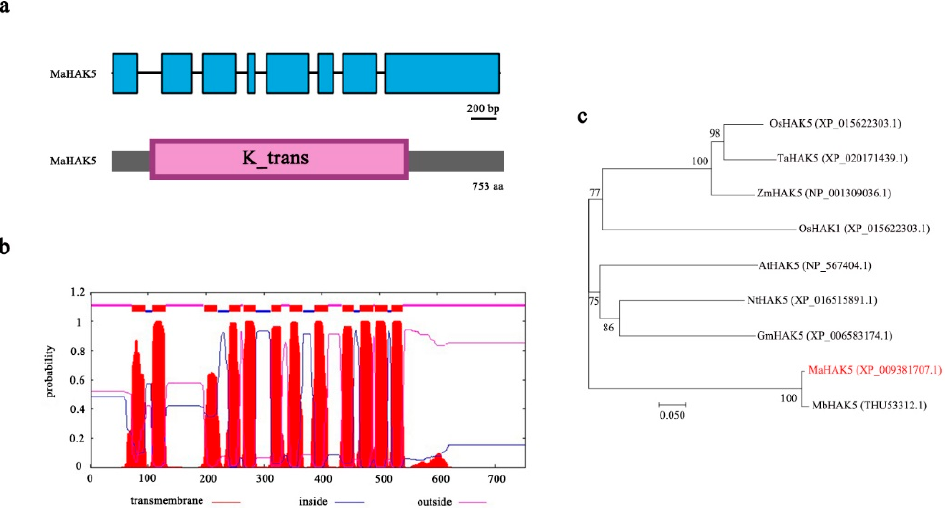
Figure 1. Cloning and bioinformatic analysis of MaHAK5. ( a ) Genomic structure and functional domain of MaHAK5 . The blue boxes indicate exons; the pink box indicates the K + transporter domain. ( b ) Transmembrane domain prediction of the MaHAK5 protein. ( c ) Phylogenetic analysis of HAK5s from different plant species and homologous sequences of other species. The scale bar represents a substitution distance of 0.05. Ta, Triticum aestivum ; Os, Oryza sativa ; Zm, Zea mays ; Ma, Musa acuminata ; Mb, Musa balbisiana ; Gm, Glycine max ; Nt, Nicotiana tabacum ; At, Arabidopsis thaliana .